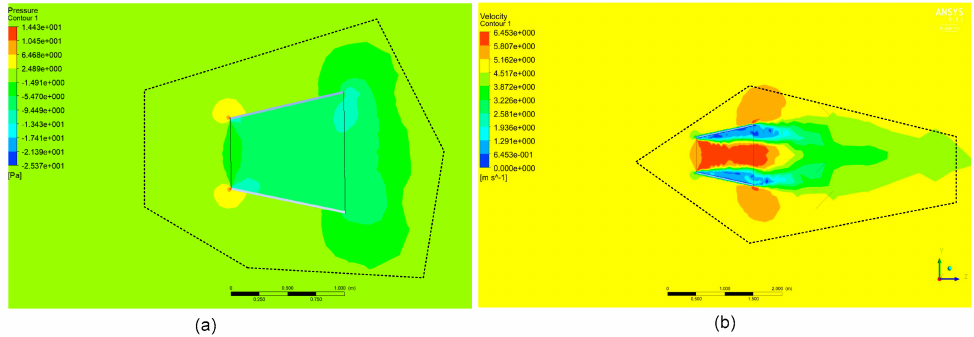
Figure 8. Contours around and within the diffuser: ( a ) pressure; ( b )